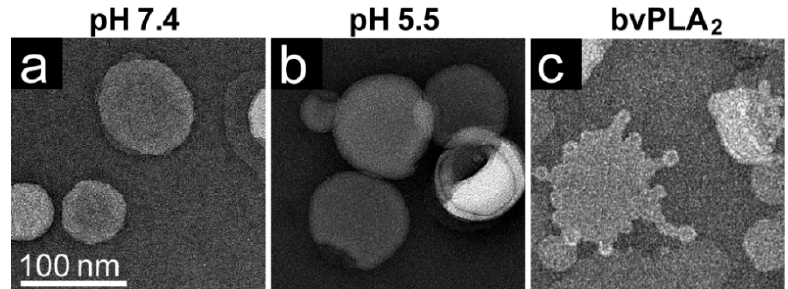
Figure 5. POPC liposome remodeling in the presence of PLA 2 . Liposomes ( a ) at pH 7.4, ( b ) pH 5.5, and ( c ) in presence of bee venom PLA 2 (bvPLA 2 ) at pH 7.4. Bleb formation of POPC liposomes was observed in ( c ). All experiments were performed in triplicate.